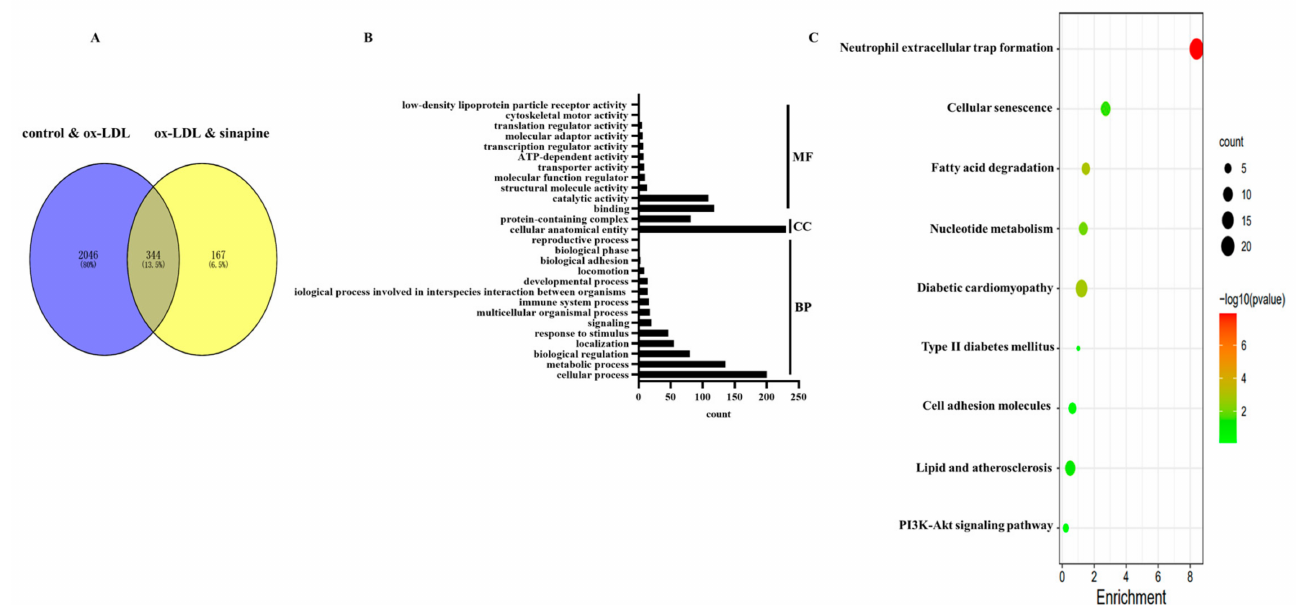
Figure 4. Bioinformatics analysis of DEPs in the control group, ox-LDL group, and sinapine group. ( A ) Venn plot of identified control vs. ox-LDL and ox-LDL vs. sinapine proteins in foam cells. ( B ) GO enrichment analysis of DEPs. ( C ) The above pathways were significantly enriched according to KEGG pathway enrichment analysis ( p < 0.05). Gradual changes from green to red indicate progressively lower p -values, colors indicate significant enrichment levels, and the size of the circles indicates the number of